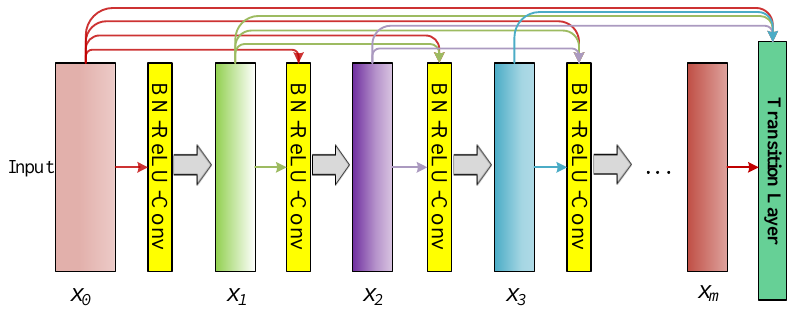
Figure 5. Structure of the dense block.